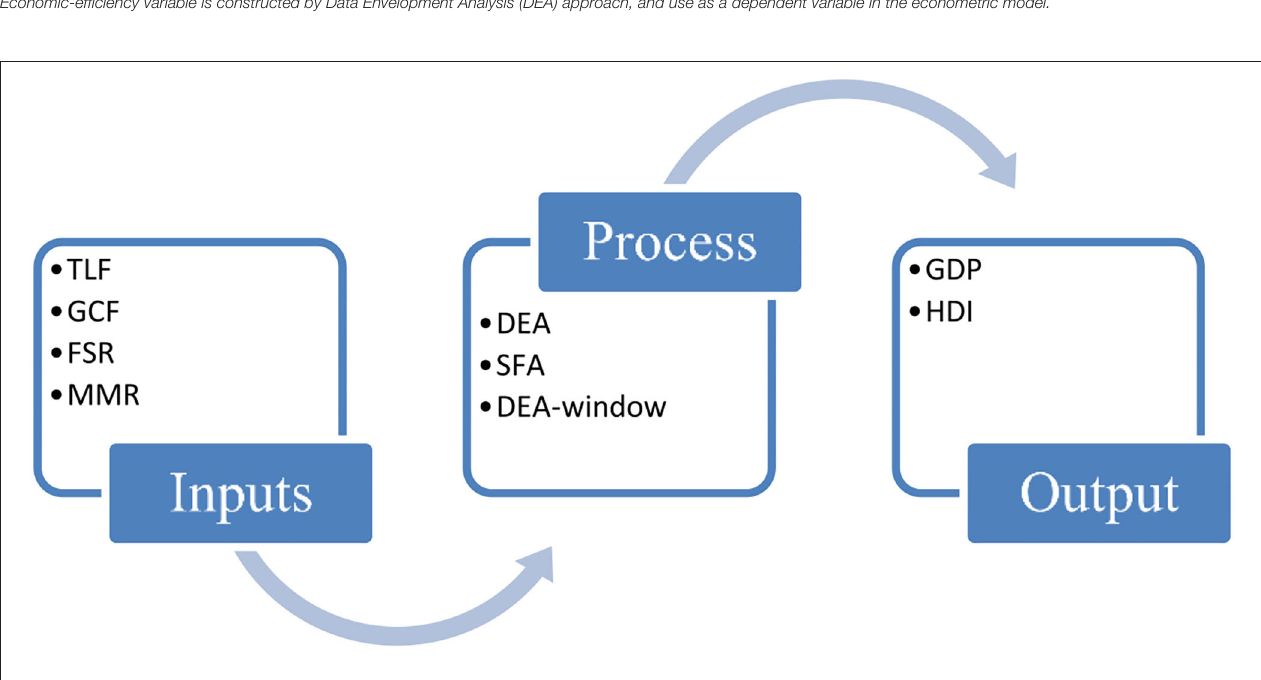
FIGURE 1 | Economic transformation of resources.